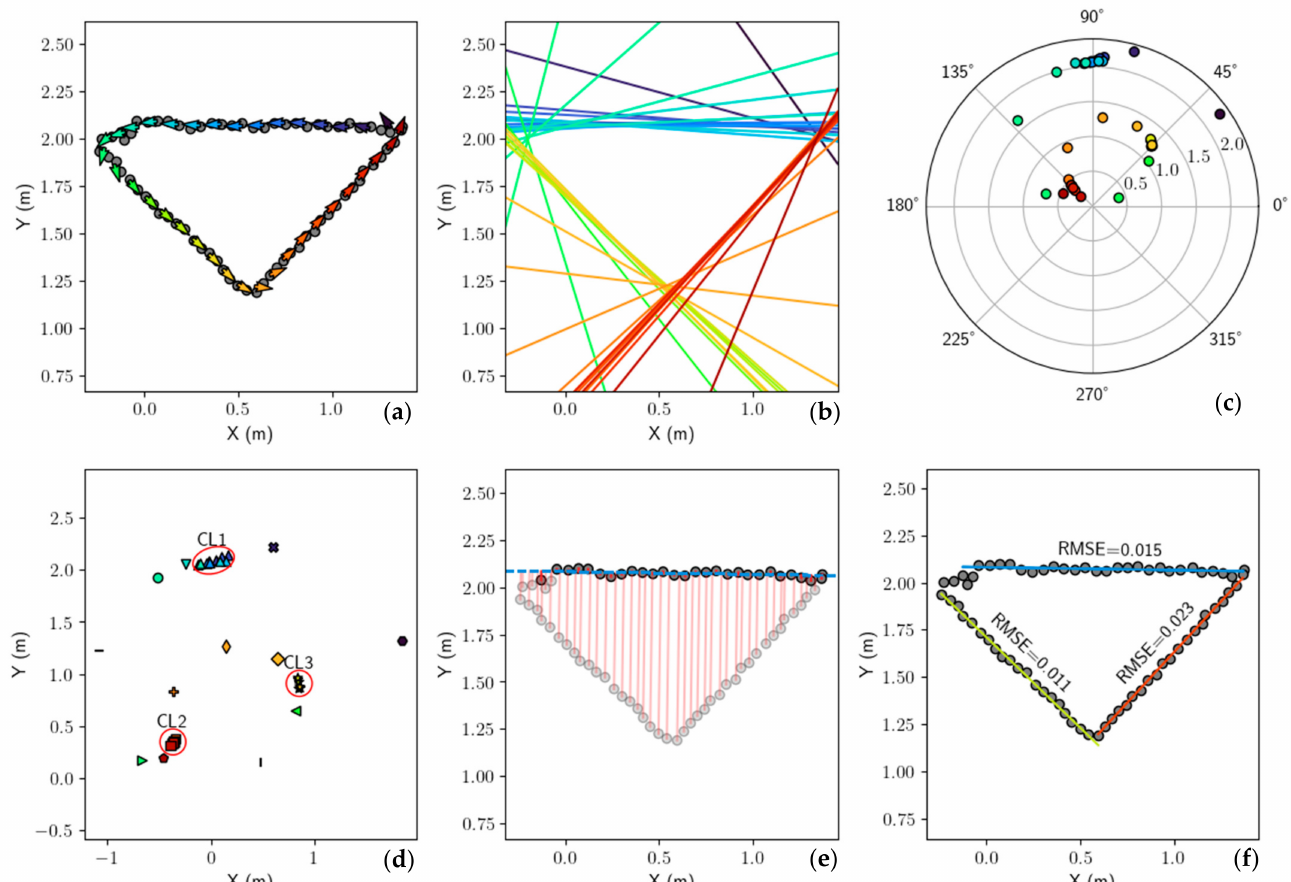
Figure 7. Creating refined line estimates of a polygon. ( a ) Each line segment of the polygonal chain is converted to point/vector form. Color denotes the position in the polygonal chain and is kept constant throughout all plots. ( b ) Vectors shown as full line estimates for better visualization. ( c ) Vectors are converted to Hess normal form whose parameters (angle/offset) are shown on a polar plot. ( d ) The points are transformed to Euclidean space and clustered using AHC. Three clusters are circled in red, which pass constraints. ( e ) The mean of each cluster (only blue shown) is evaluated against all data and inliers are used to refit a final least-squared fit line. ( f ) Final line set